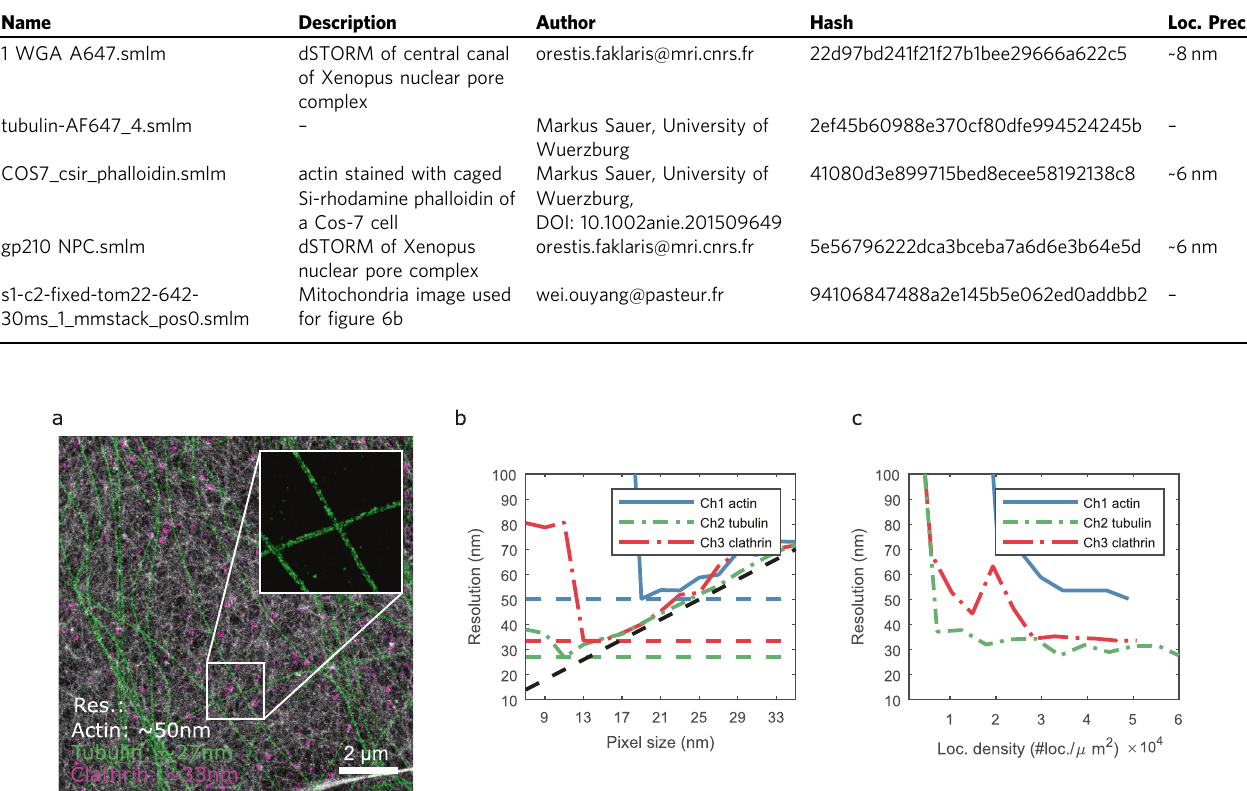
Fig. 4 Resolution estimation of multi-color STORM data. a Bilinear histogram rendering at 5 nm pixel size. Actin (phalloidin-AF647; STORM; gray colormap), microtubules (two anti- α -tubulin antibodies; STORM; green colormap) and clathrin-coated pits (anti-clathrin light chain; Atto655 imager; DNA- PAINT; red colormap). b Resolution vs pixel size. c Resolution as a function of the loc. density. Scale bar: 2 µ